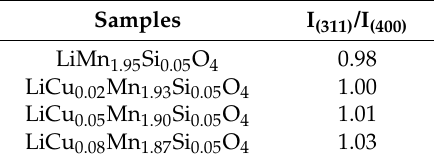
Table 1. Intensity ratio of (311)/(400) peaks of LiCu x Mn 1.95 − x Si 0.05 O 4 (x = 0, 0.02, 0.05, 0.08) samples.